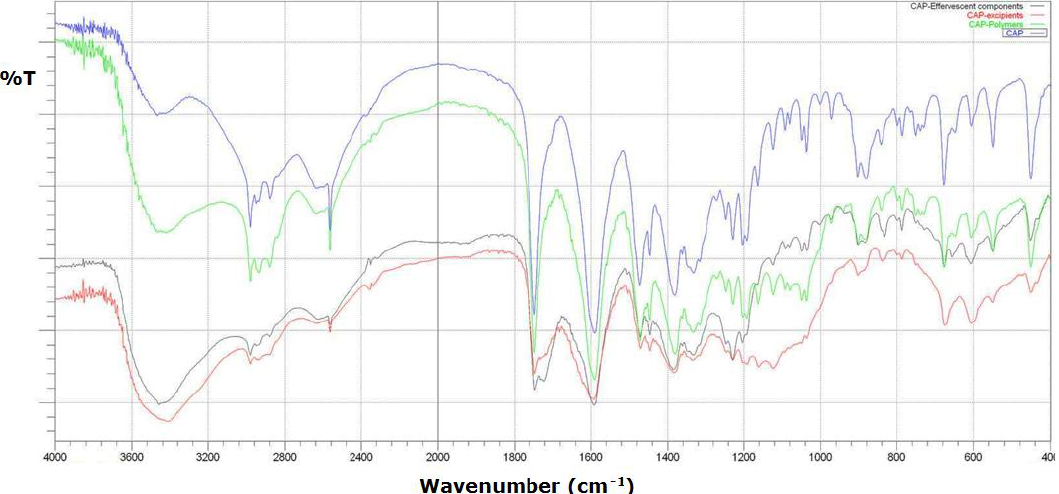
Figure 1. FT-IR spectrum of mixture between CAP and excipients (blue band : CAP, green band : CAP-polymers, black band : CAP-effervescent components, red band : CAP-all